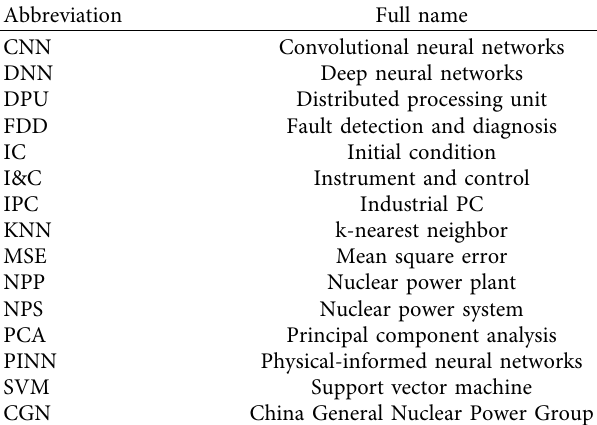
Table 1: List of